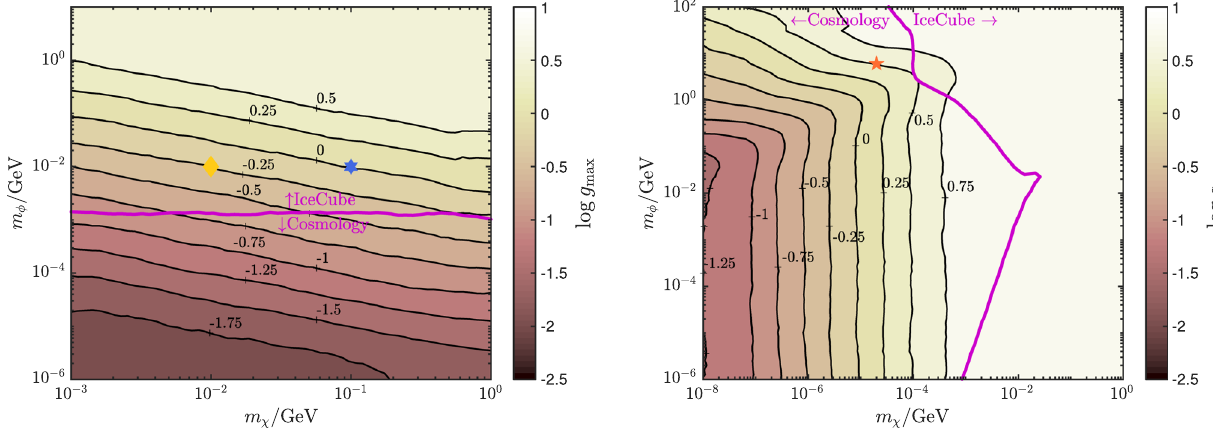
Fig. 31 Contours of the maximum allowed value of the coupling of dark matter to neutrinos, g max , as a function of the dark matter mass, m χ , and the mediator mass m φ . Left panel: fermionic dark matter cou- pled through a vector mediator. Right panel: scalar dark matter coupled through a fermionic mediator. The magenta line in both plots delim- its the region where cosmological observations from large scale struc-